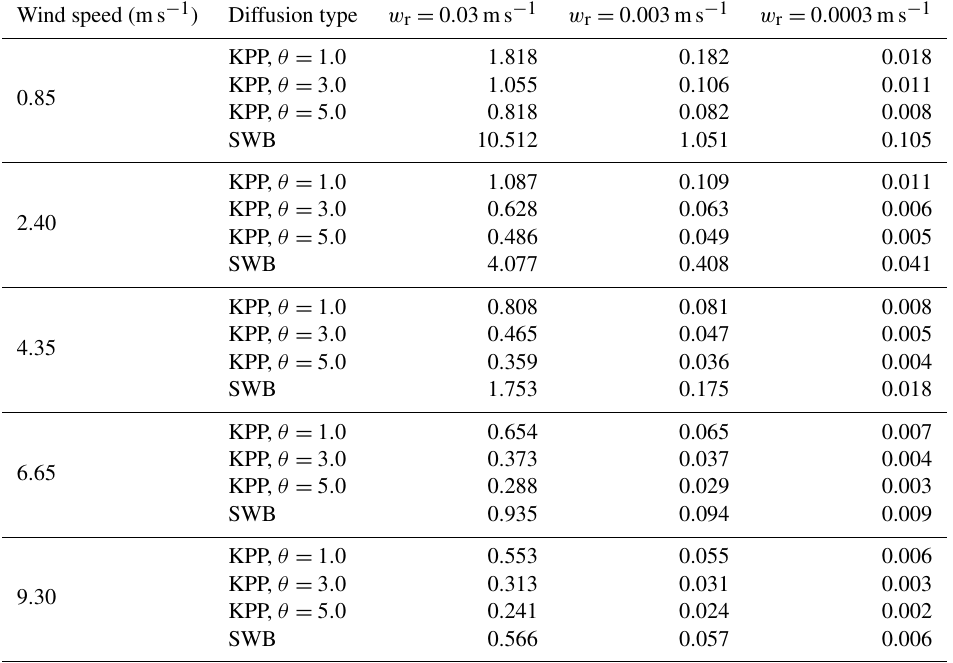
Table A1. Ratios w r /w (cid:48) between the rise velocity w r and the peak stochastic velocity perturbation w (cid:48) for KPP and SWB diffusion. The peak w (cid:48) is the maximum value of Eq. (3). The peak w (cid:48) values for KPP diffusion are calculated for θ ∈ [ 1 . 0 , 3 . 0 , 5 . 0 ] and for z 0 following Eq. (12). The peak w (cid:48) values for SWB diffusion are independent of γ .